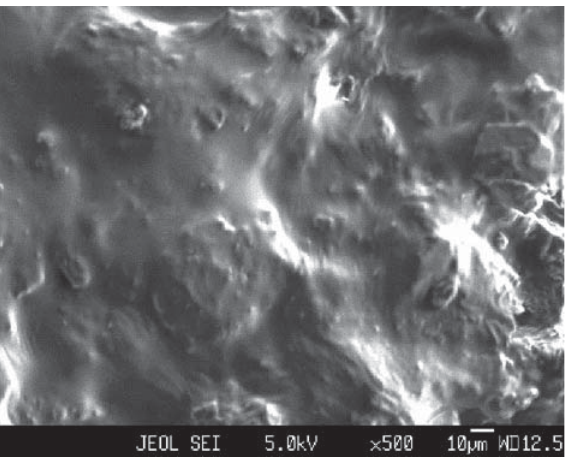
Figure 2 – Scanning electron micrographs of the transdermal film showing uniform distribution of drug in polymeric